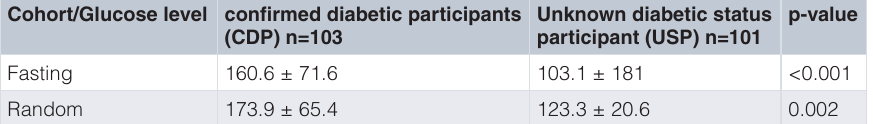
Table 3. Mean glucose levels with standard deviation for the two groups and the types of screening and the related